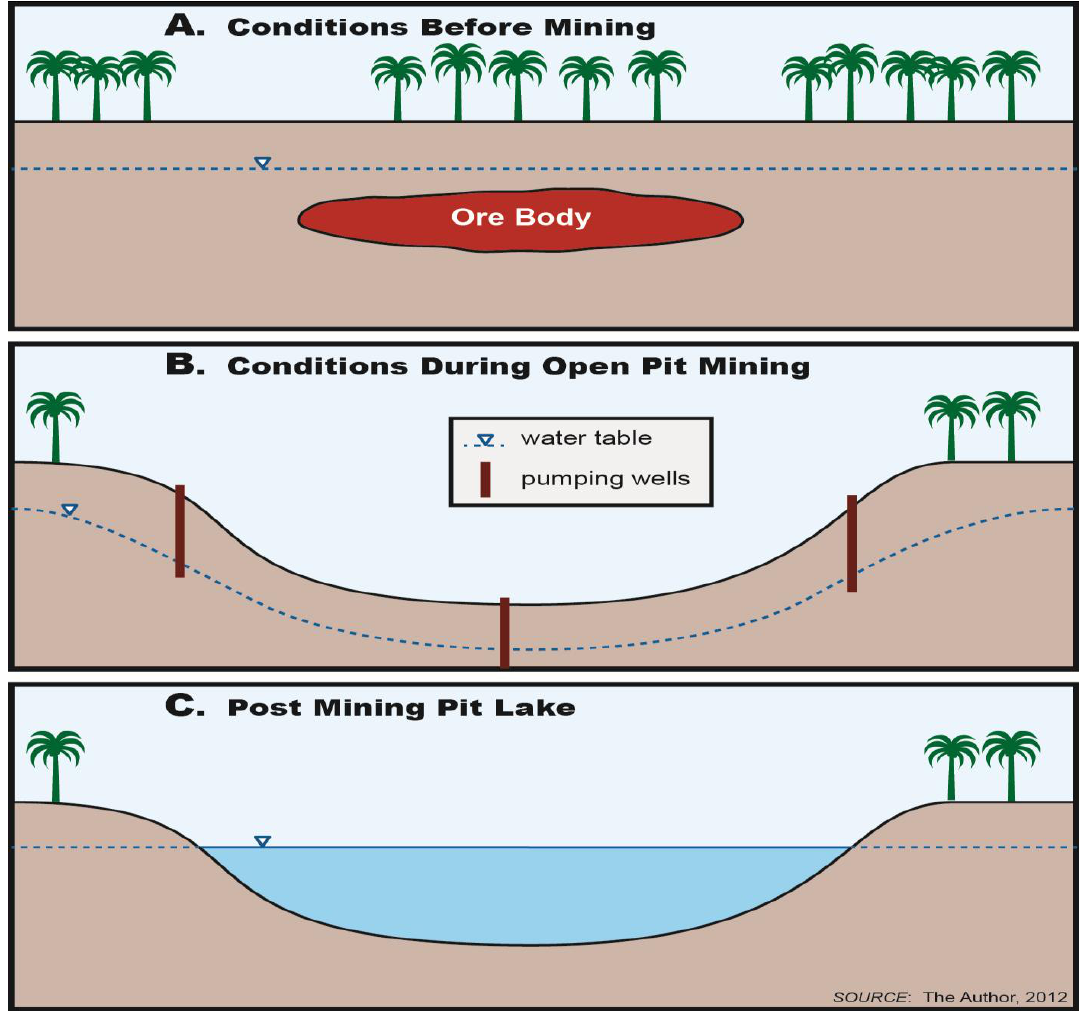
Figure 4. The Process of Mine Pit